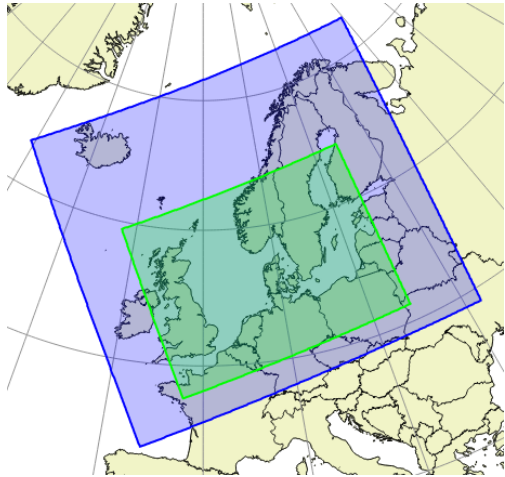
domain (Yang et al., 2017) (November 2016–January 2021),